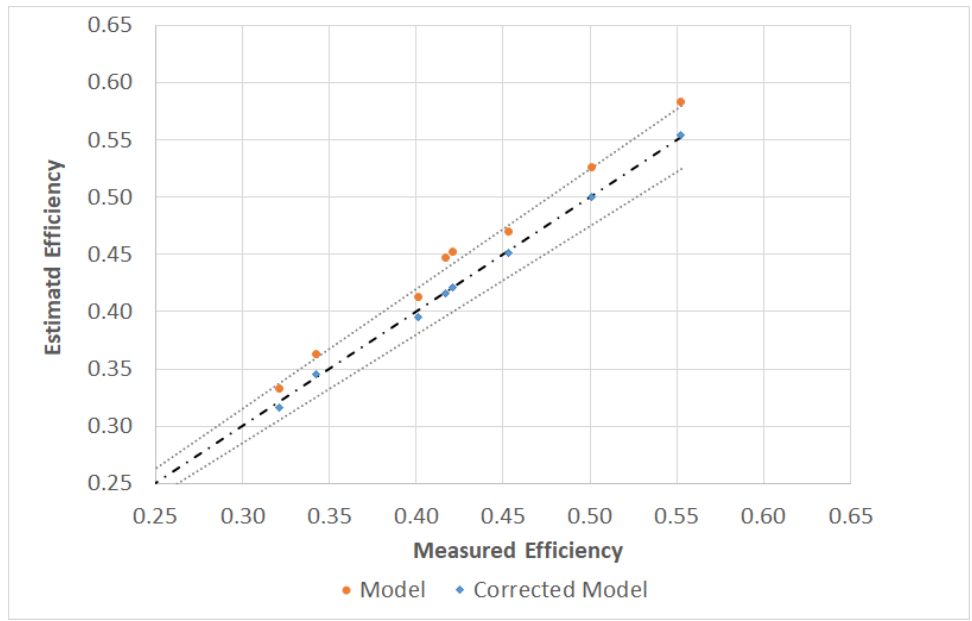
Figure 11. Validation and calibration of the model for HARDI ISO F-110-04 nozzles.